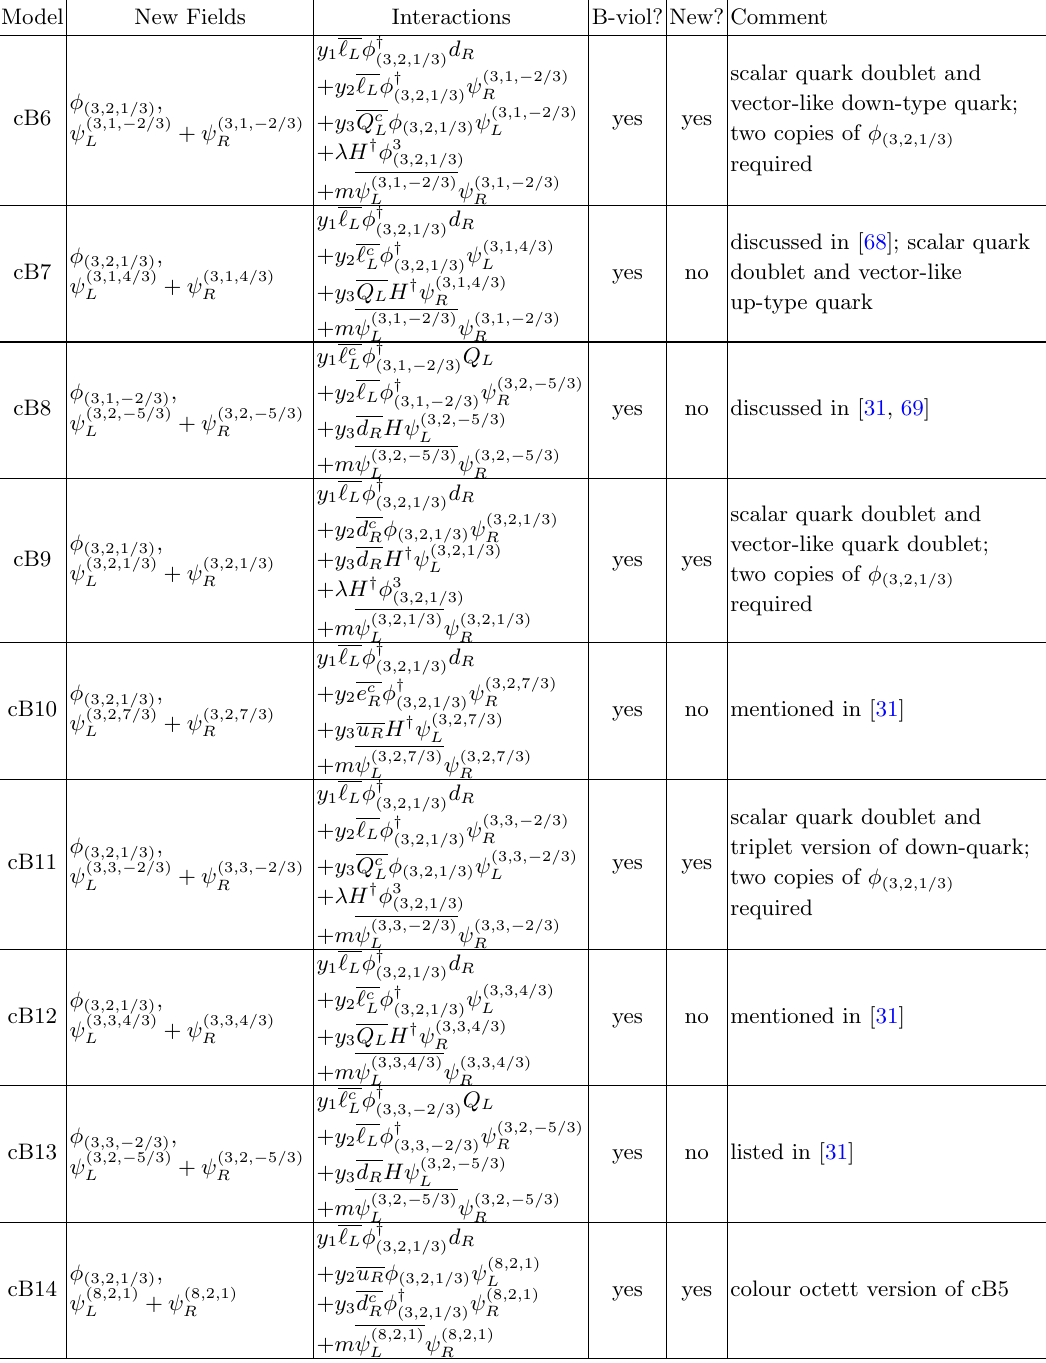
Table 5 : Neutrino mass models with one new scalar and one new vector-like Dirac fermion with at least one coloured